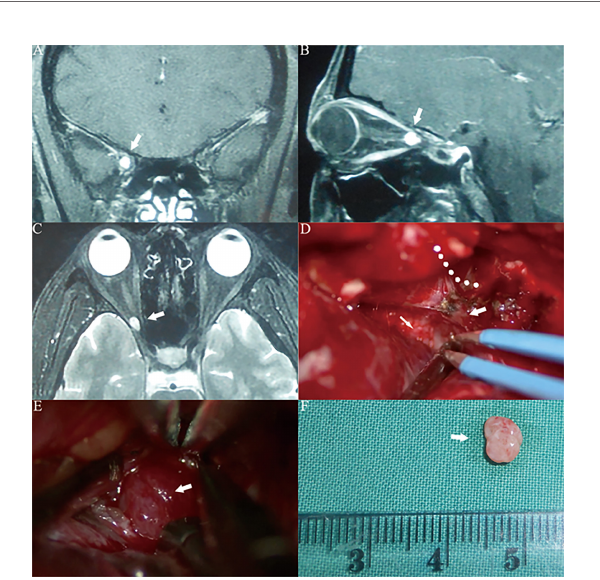
FIGURE 6 | Case4. A 34-year-old female presented with her right eye vision loss for 2 months and sudden loss of right eye vision for 2 weeks. She was misdiagnosed as optic atrophy in the local hospital and was given hormone therapy. (A – C) MRI of the optic nerve showed a space-occupying lesion in the ring of the common tendon in the right orbital apex area, with uniform enhancement, and the tumor diameter was less than 1 cm (white thick arrow). (D) The tumor is located lateral the optic nerve. We used a right frontal-orbital approach craniotomy to remove the tumor. Abrasion of the optic canal bone shows the right optic nerve (white thin arrow), abrasion of the superior orbital fi ssure bone shows the right superior orbital fi ssure (white thick arrow), and the orbital periosteum at the orbital apex is incised lateral the superior orbital fi ssure along the dotted line. (E) It can be seen that the tumor capsule is intact, light red, and located lateral the right optic nerve (white thick arrow). (F) The tumor can be seen after complete resection. The actual tumor diameter is about 5mm (white thick